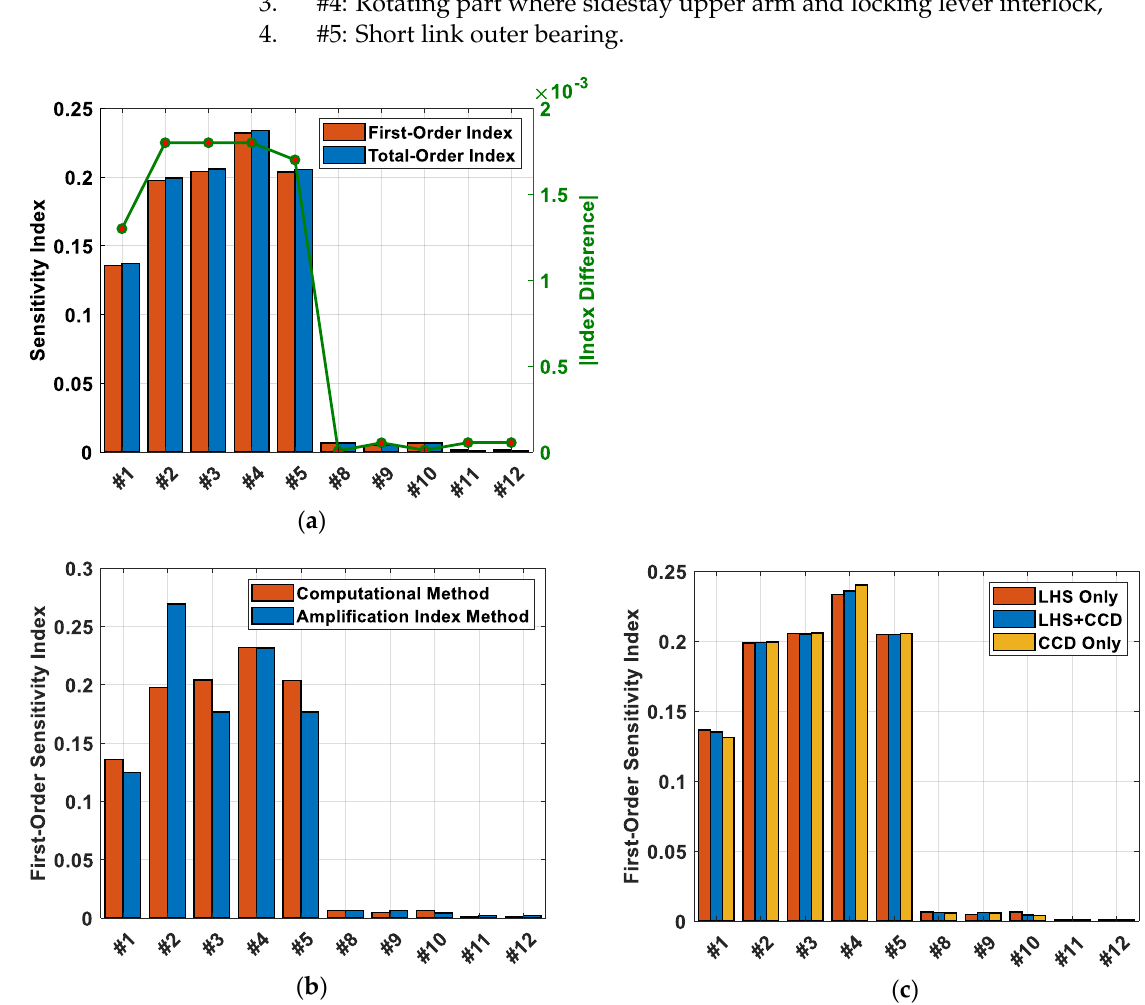
Figure 13. Sensitivity analysis results. ( a ) Sensitivity index (LHS) by computational method. ( b ) Comparison of first-order indices by computational and amplification index methods. ( c ) Comparison of first-order indices by experimental designs.